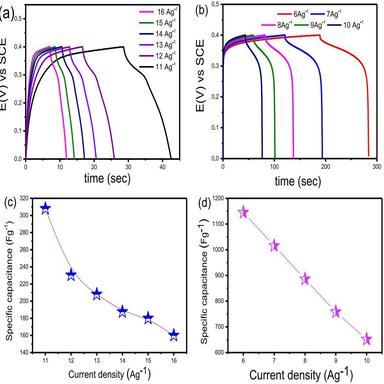
Galvanostatic charge− discharge profile of LBG-cl-PAN- IONP electrode in (a) KH with changing current density from 11 to 16 Ag-1; (b) 3 KH + 0.1RE with changing current density from 6 to 10 Ag-1. Change of specific capacitance of LBG-cl-PAN- IONP electrodes in (c) 3 KH with changing current density from 11 to 16 Ag-1; (d)3 KH+0.1RE with changing current density from 6 to 10 Ag-1.